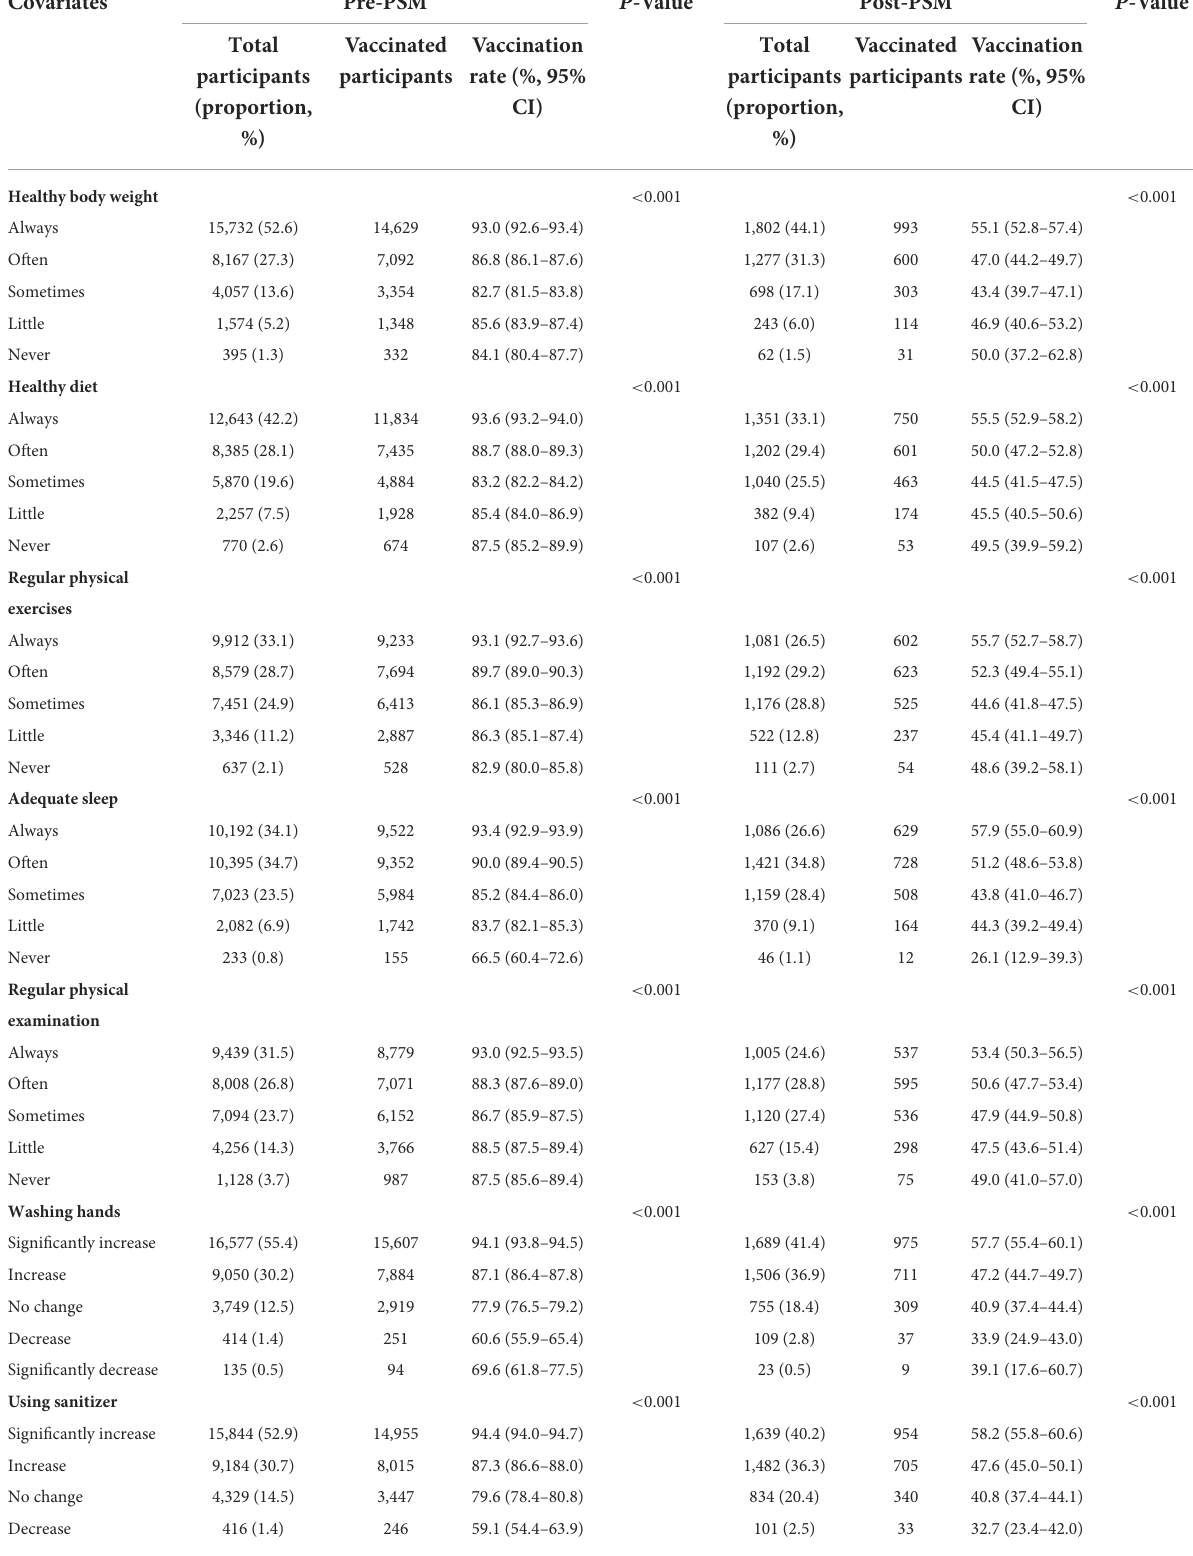
TABLE 3 The COVID-19 vaccination rates among 12 items of lifestyle pre- and post-PSM. Covariates Pre-PSM P -Value Post-PSM P -Value